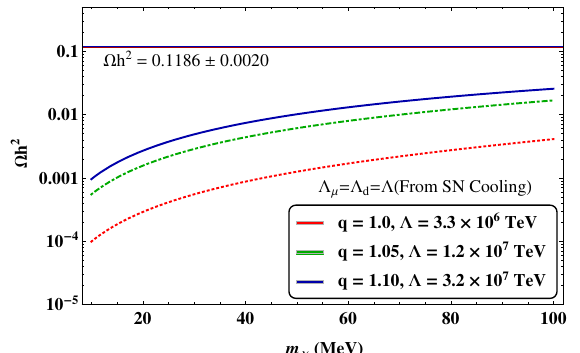
Figure 2 . (cid:10) h 2 are plotted against m (cid:31) (in MeV) for q = 1 ; 1 : 05 and1 : 1 for the value of (cid:3) ((cid:3) (cid:22) = (cid:3) d = (cid:3), Case III) obtained using Ra(cid:11)elt’s criteria [7].